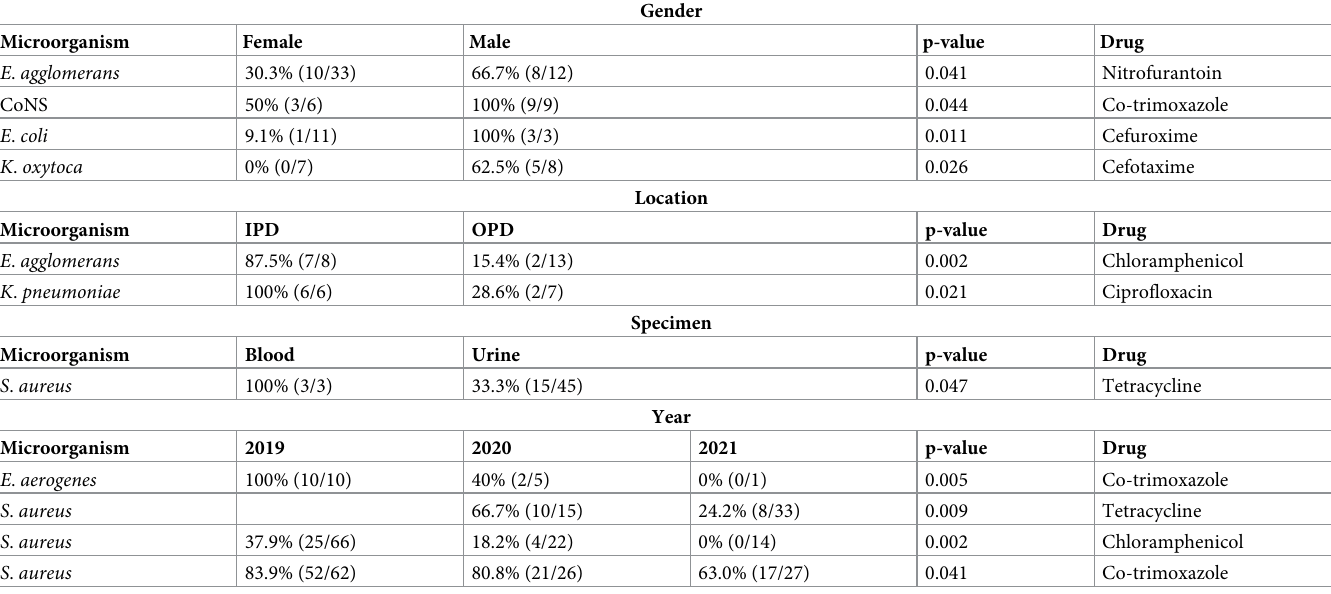
Table 1. The resistant pattern of some bacteria isolates with respect to patient location, year of isolation, patient gender, and specimen